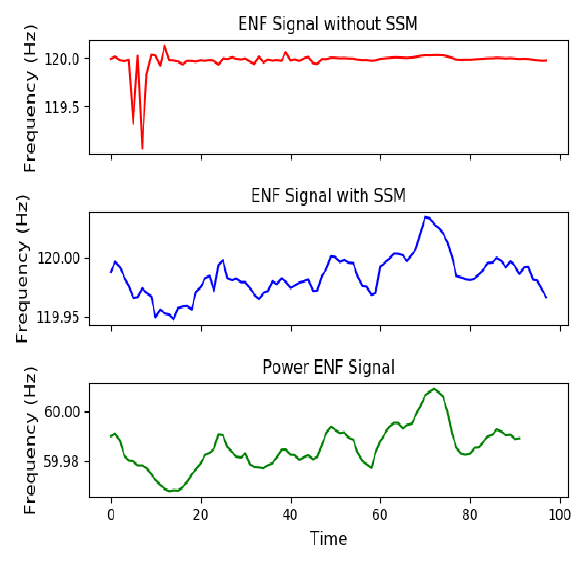
Figure 9. ENF signal of a video recording where the first half of the recording includes moving subject.